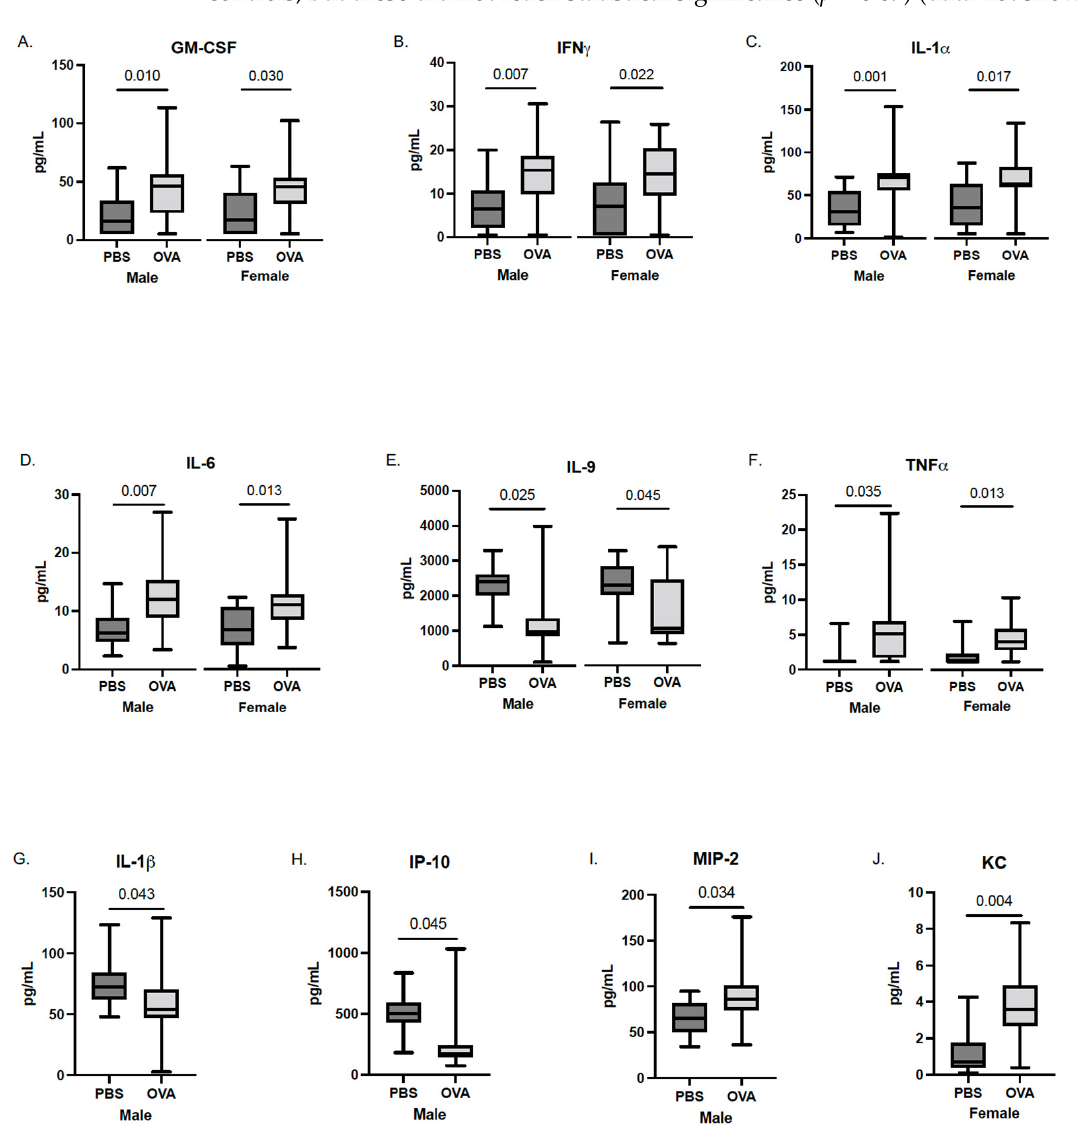
Figure 3. Cytokine concentrations in the fetal brain (whole-brain homogenates) taken at GD17.5 following final maternal asthma challenge. Concentrations of cytokines from male and female offspring of OVA- and PBS-exposed dams were assessed using a multiplex bead-based immunoassay. The concentrations of ( A ) GM-CSF, ( B ) IFN γ , ( C ) IL-1 α , ( D ) IL-6, ( E ) IL-9, ( F ) TNF α , ( G ) IL-1 β , ( H ) IP-10, ( I ) MIP-2, and ( J ) KC are represented as pg/mL after being normalized to total protein content. Statistical significance determined by multilevel mixed-effects modeling.